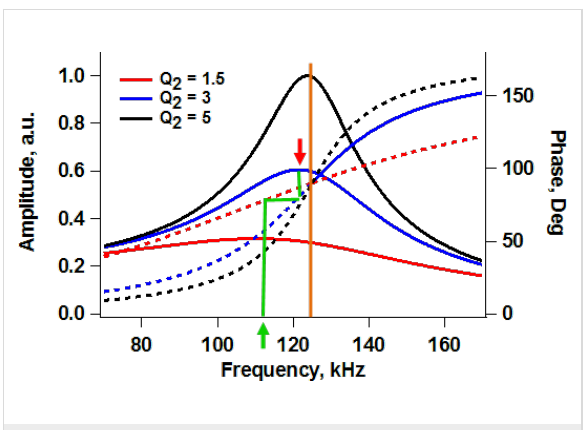
Figure 10: Cantilever amplitude and phase response for various levels of damping in low- Q environments. The thick red and green arrows and the green line illustrate the nature of the errors made in deter- mining the resonance frequency when a frequency modulation opera- tion is locked to the peak frequency instead of the natural frequency (see discussion in the